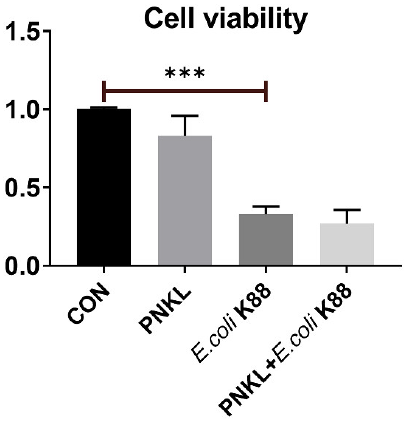
Figure 4. Influence of PNKL on E. coli K88-induced cell viability in IPEC-J2 cells. IPEC-J2 was determined by incubation with CCK8 for 1 h after different treatments. *** Means significant difference compared with blank control group ( p < 0.001).